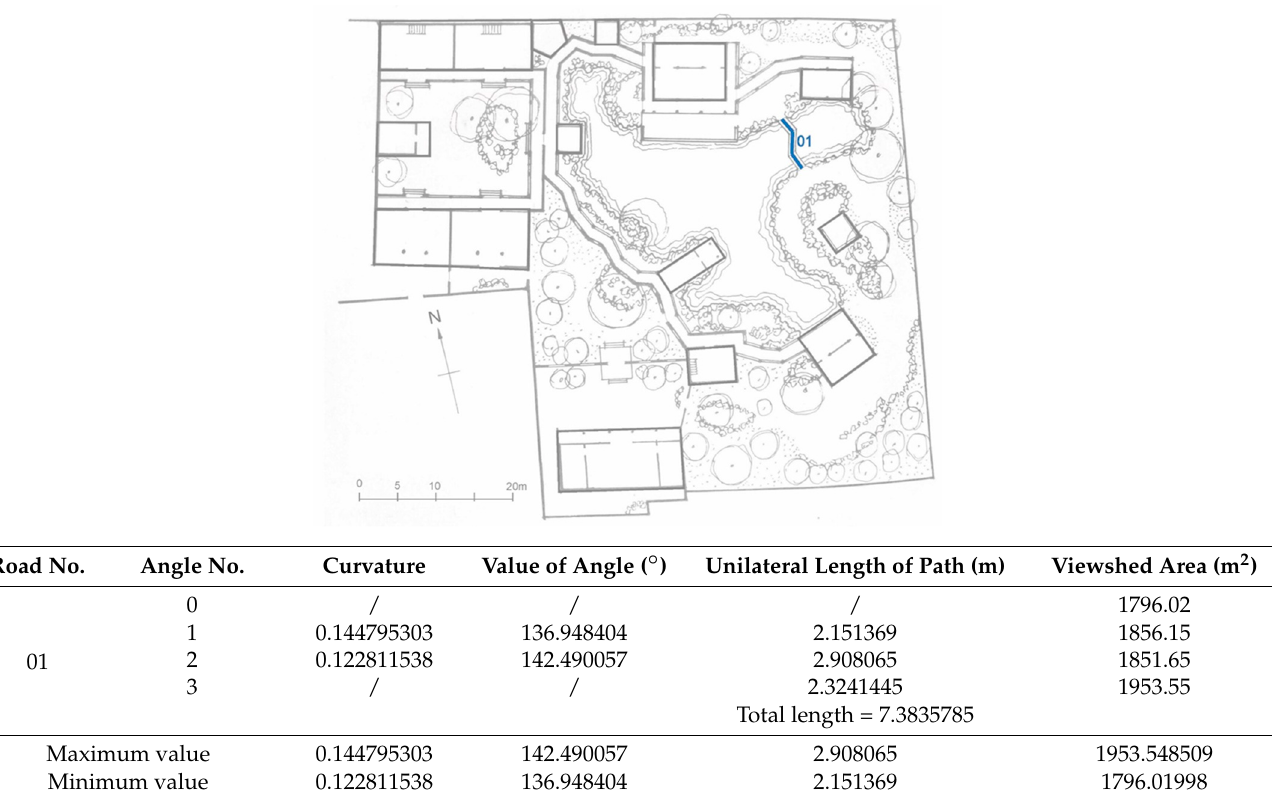
Table A27. Couple’s Garden Retreat,